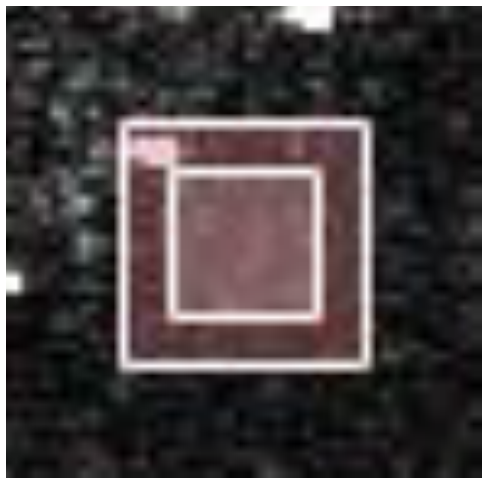
Figure 4. Two search windows centered on P 4 with outer and inner frame sizes of 25 and 15, respectively. A bright structure is evident between these two frames, which did not affect the homogeneous factor calculated using Equation (6) in the inner frame. Homogenous factors of 0.9032 and 0.1942 were produced by the large and small windows, respectively.